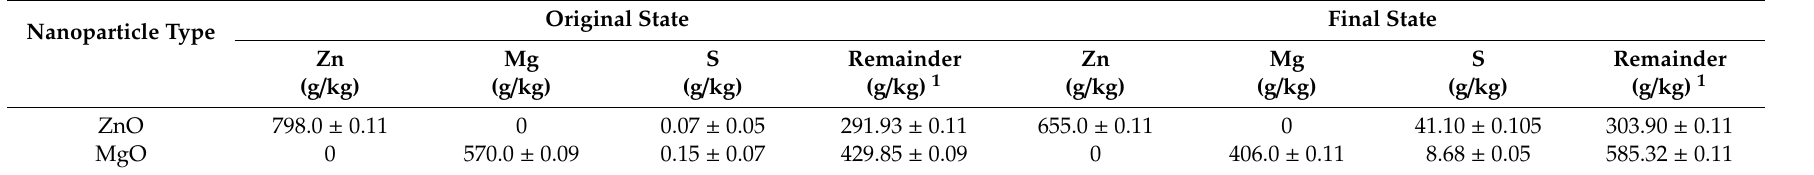
Table 3. ICP-OES results of inorganic nanoparticles before and after being subjected to polymerization conditions. Nanoparticle Type